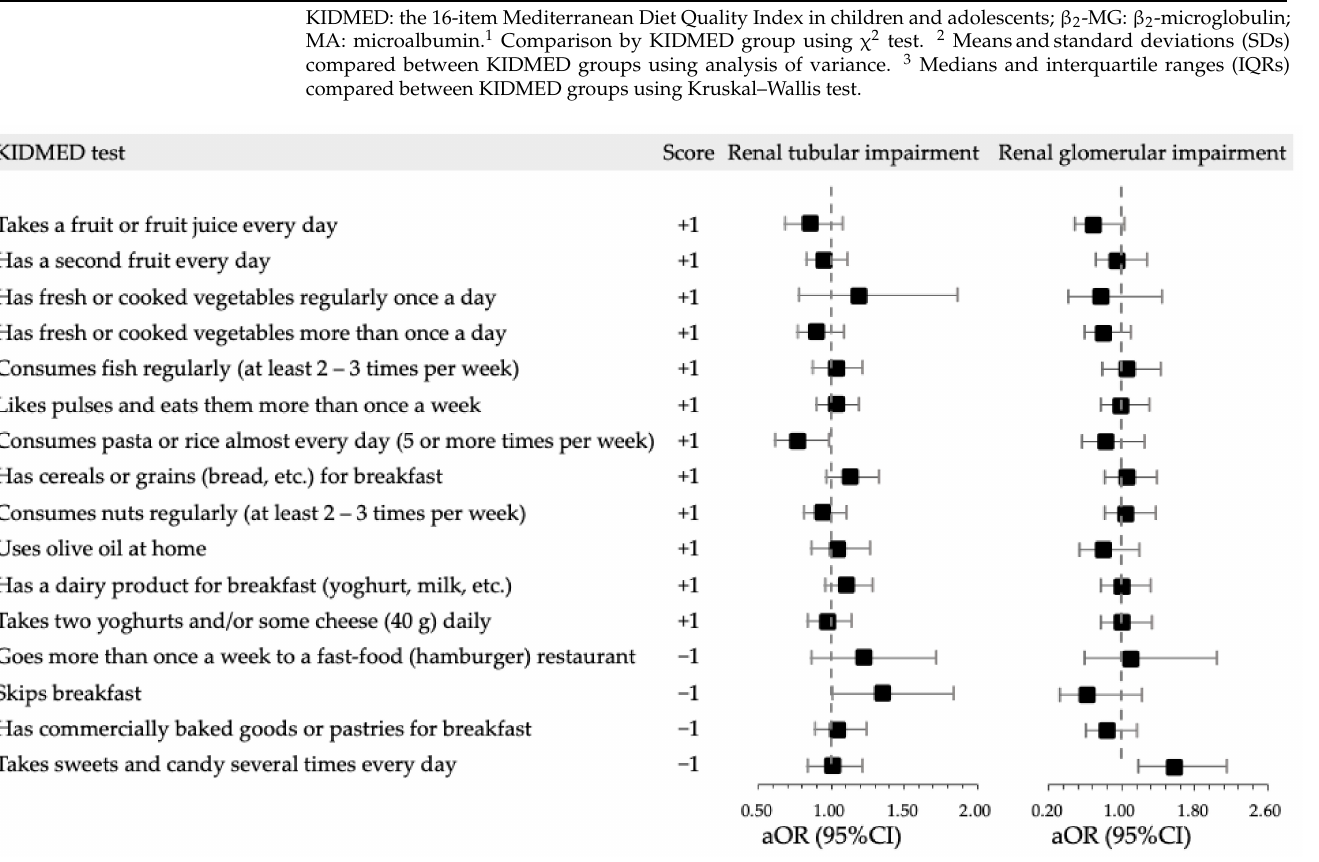
Figure 1. Forest plot for longitudinal associations of 16 items in KIDMED test with transient kidney impairment. All 16 items of the KIDMED test were included in the multivariable models, adjusting for sex, age, body mass index z-score, systolic blood pressure z-score, screen time, sleep duration and physical activity level, while the weekday of the urine assay was included as a random